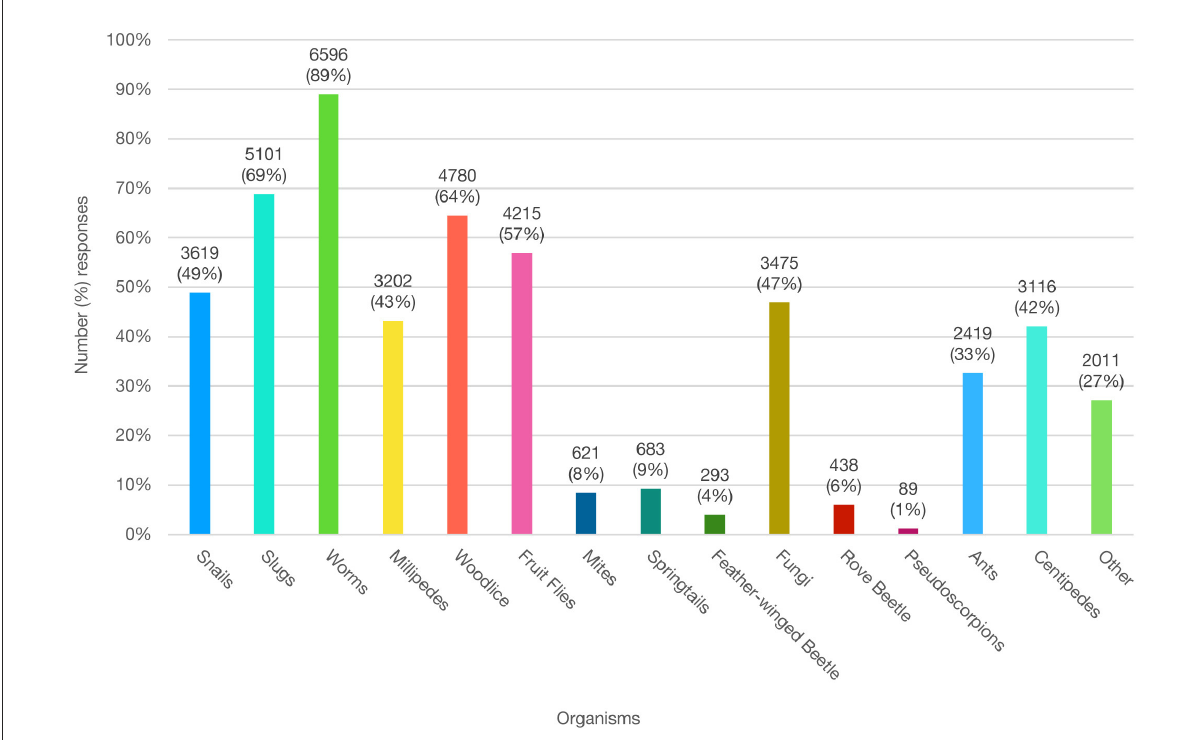
FIGURE6 Chart showing the range of organisms observed in participant composters. Values calculated from 7,413 participants who home compost. Multiple responses